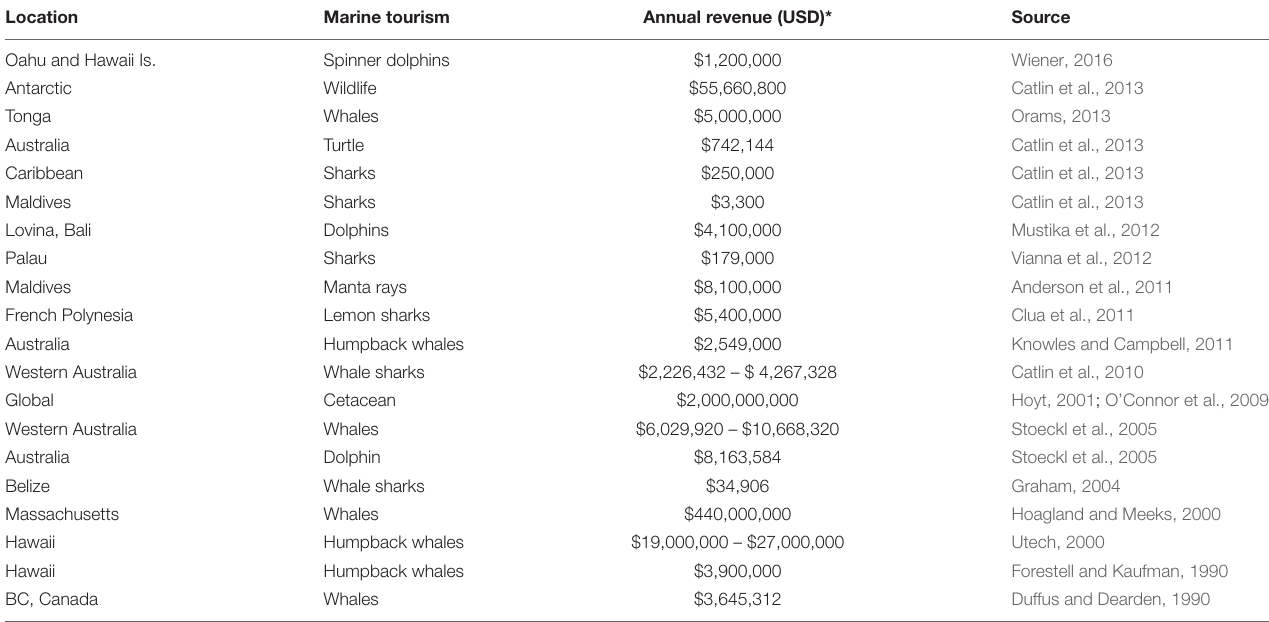
TABLE 5 | Previous marine tourism valuation